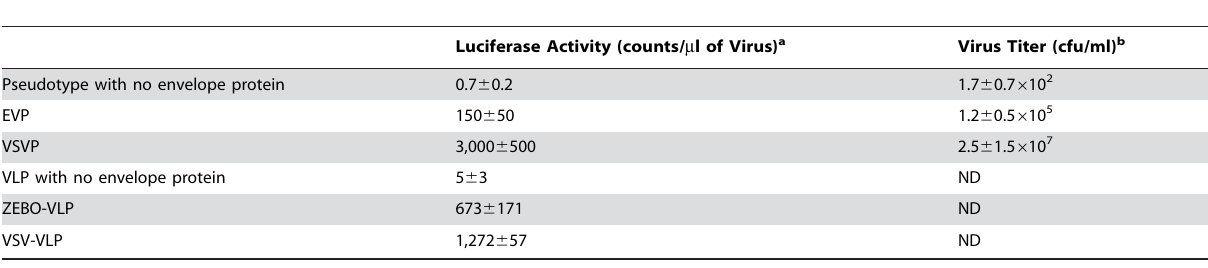
Table 1. Activity of luciferase-containing pseudotyped virus and virus-like particles in the entry assay.